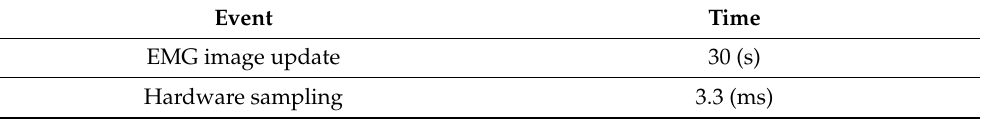
Table 4. The system operation response